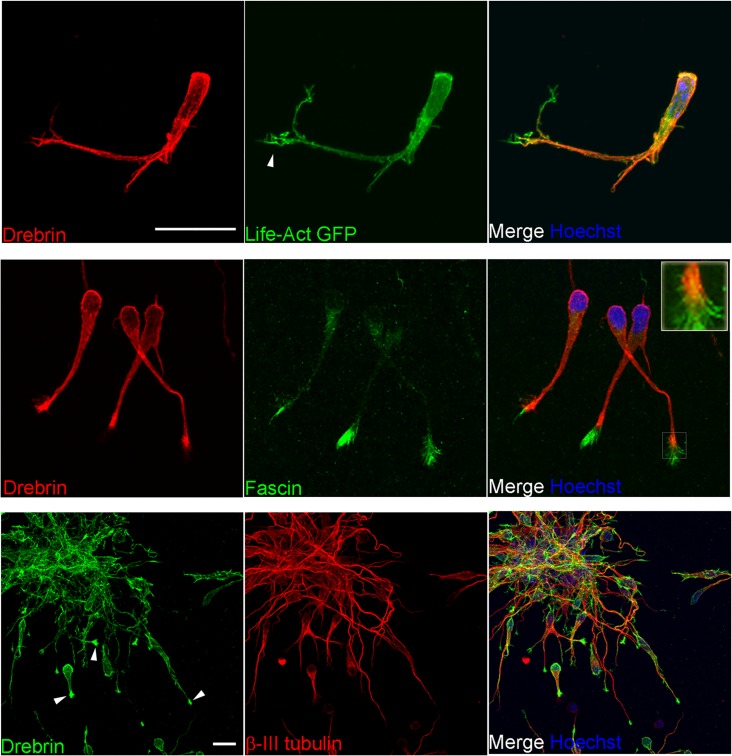
Intracellular localisation of drebrin in migratory neuroblasts.Immunostaining of cultured rat RMS neuroblasts embedded in Matrigel. (Top row) Drebrin (red) is present along the leading process but mostly excluded from peripheral filopodia, visualized by Life-Act GFP (green, arrowhead). Nuclei are stained with Hoechst dye (blue). (Middle row) Colocalization between drebrin (red) and fascin (green), which decorates peripheral filopodia, is limited to the basal region of filopodia. (Bottom row) Drebrin (green) is found along the membrane and especially concentrated towards the tip of leading processes (arrowheads), which are immunostained for ßIII tubulin-positive microtubules (red). Nuclei are stained with Hoechst dye (blue). Scale bars: (top), 10 μm; (middle and bottom), 20 μm.